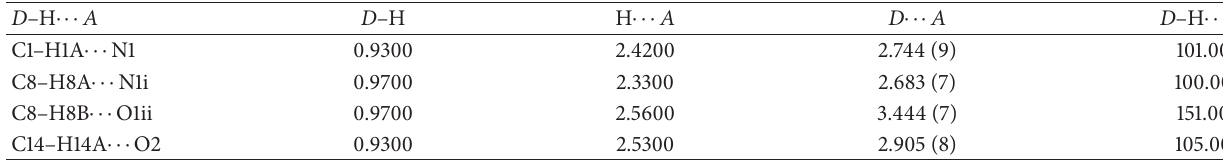
Table 2: Hydrogen-bond geometry (˚A, ∘ ) of compound 5 .